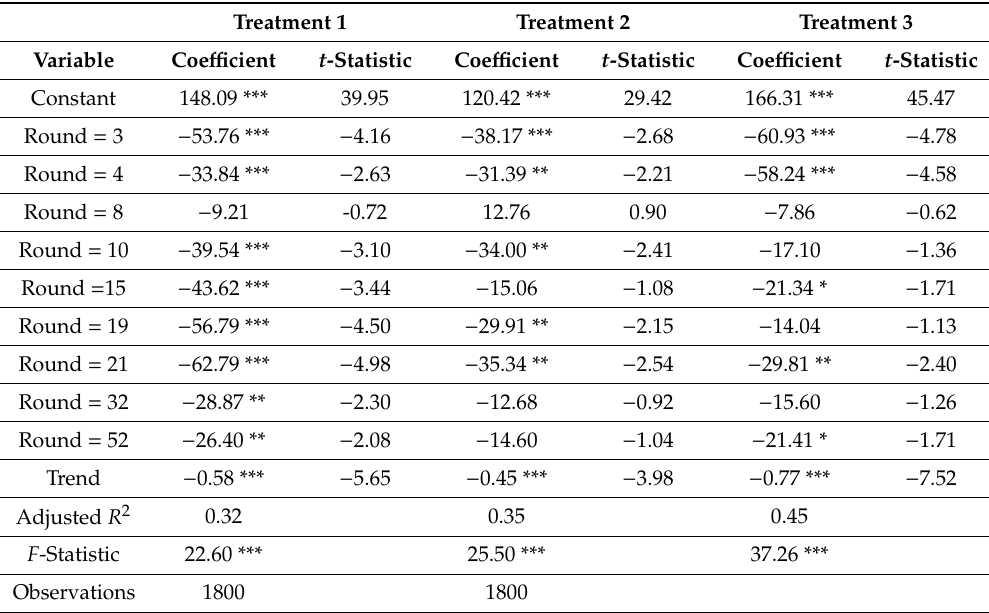
Table 5. Audit e ff ects on tax payments (individual fixed e ff